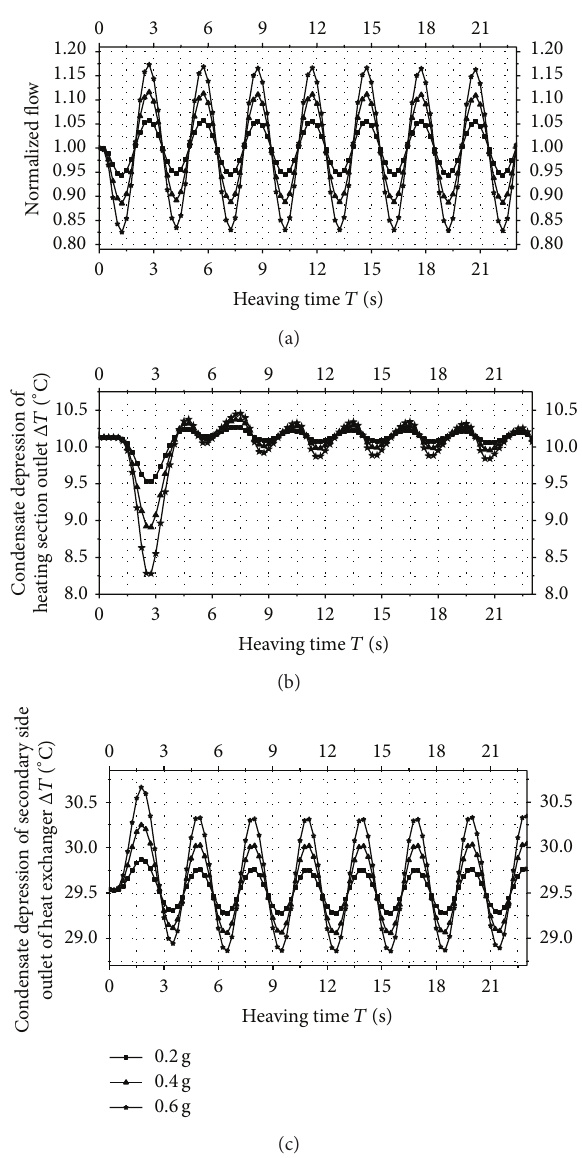
Figure 8: Flux of natural circulation, condensate depression of heating section’s outlet, and the secondary side of heat exchanger under heaving motion with cycle 𝑇 = 3 s and 𝑘 = 0.2 , 0.4, and 0.6: (a) flux of natural circulation; (b) condensate depression of heating section’s outlet; (c) secondary side of heat